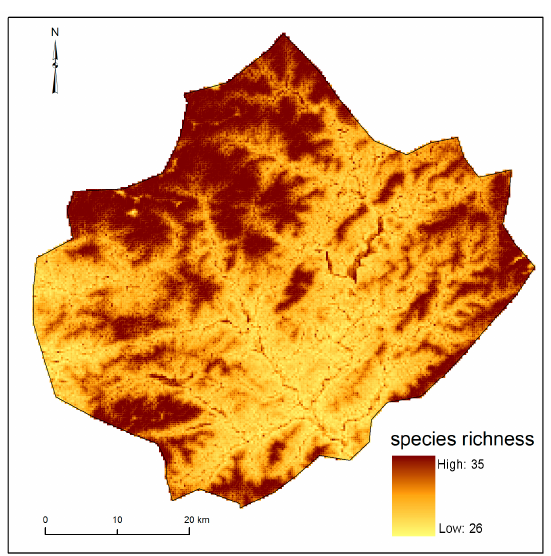
Figure 5. Spatial distribution map of predicted species richness in the study area (the pixel size is 240 m × 240 m).